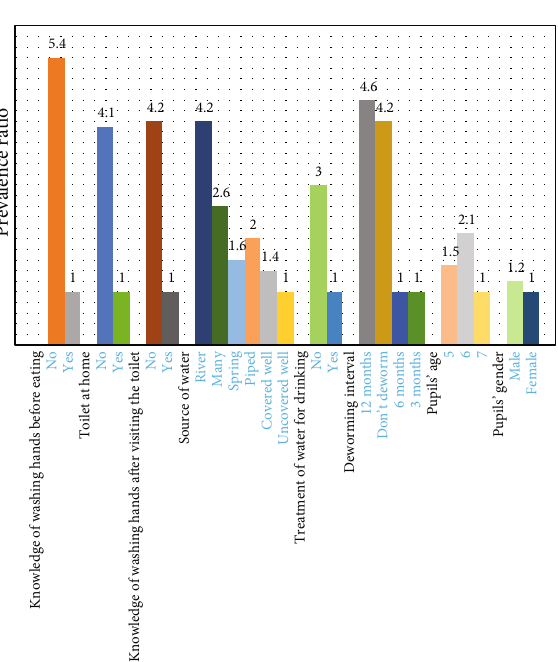
Figure 1: Association between prevalence and social factors that a ff ect helminth